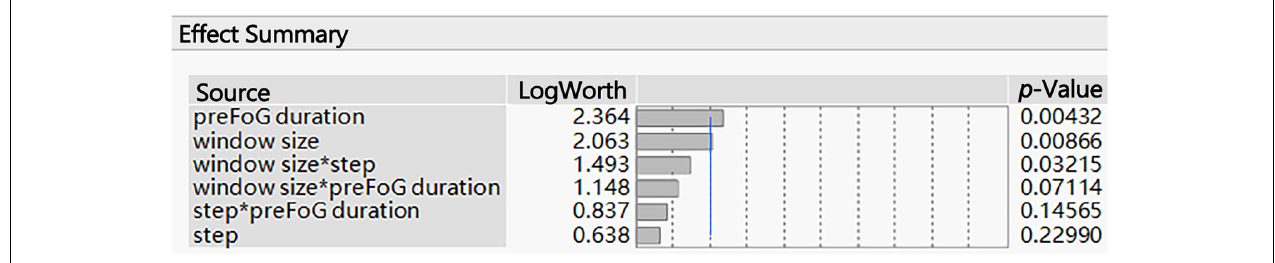
FIGURE 5 | Summary of the effects of the feature extraction parameters on the kappa value. The p -values show the statistical significance of the association between the parameters and the kappa value. *Multiplication.